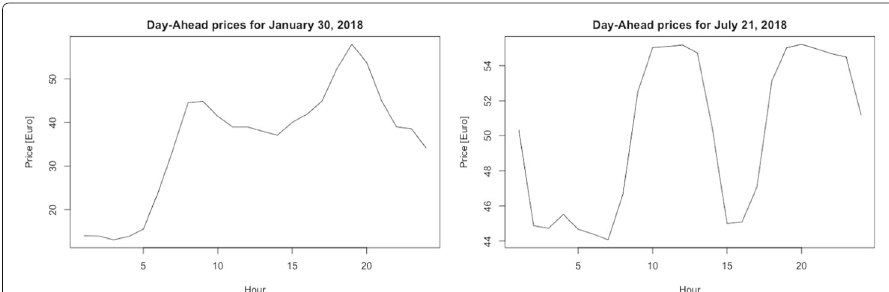
Fig. 3 Two examples for Day-Ahead prices 2018